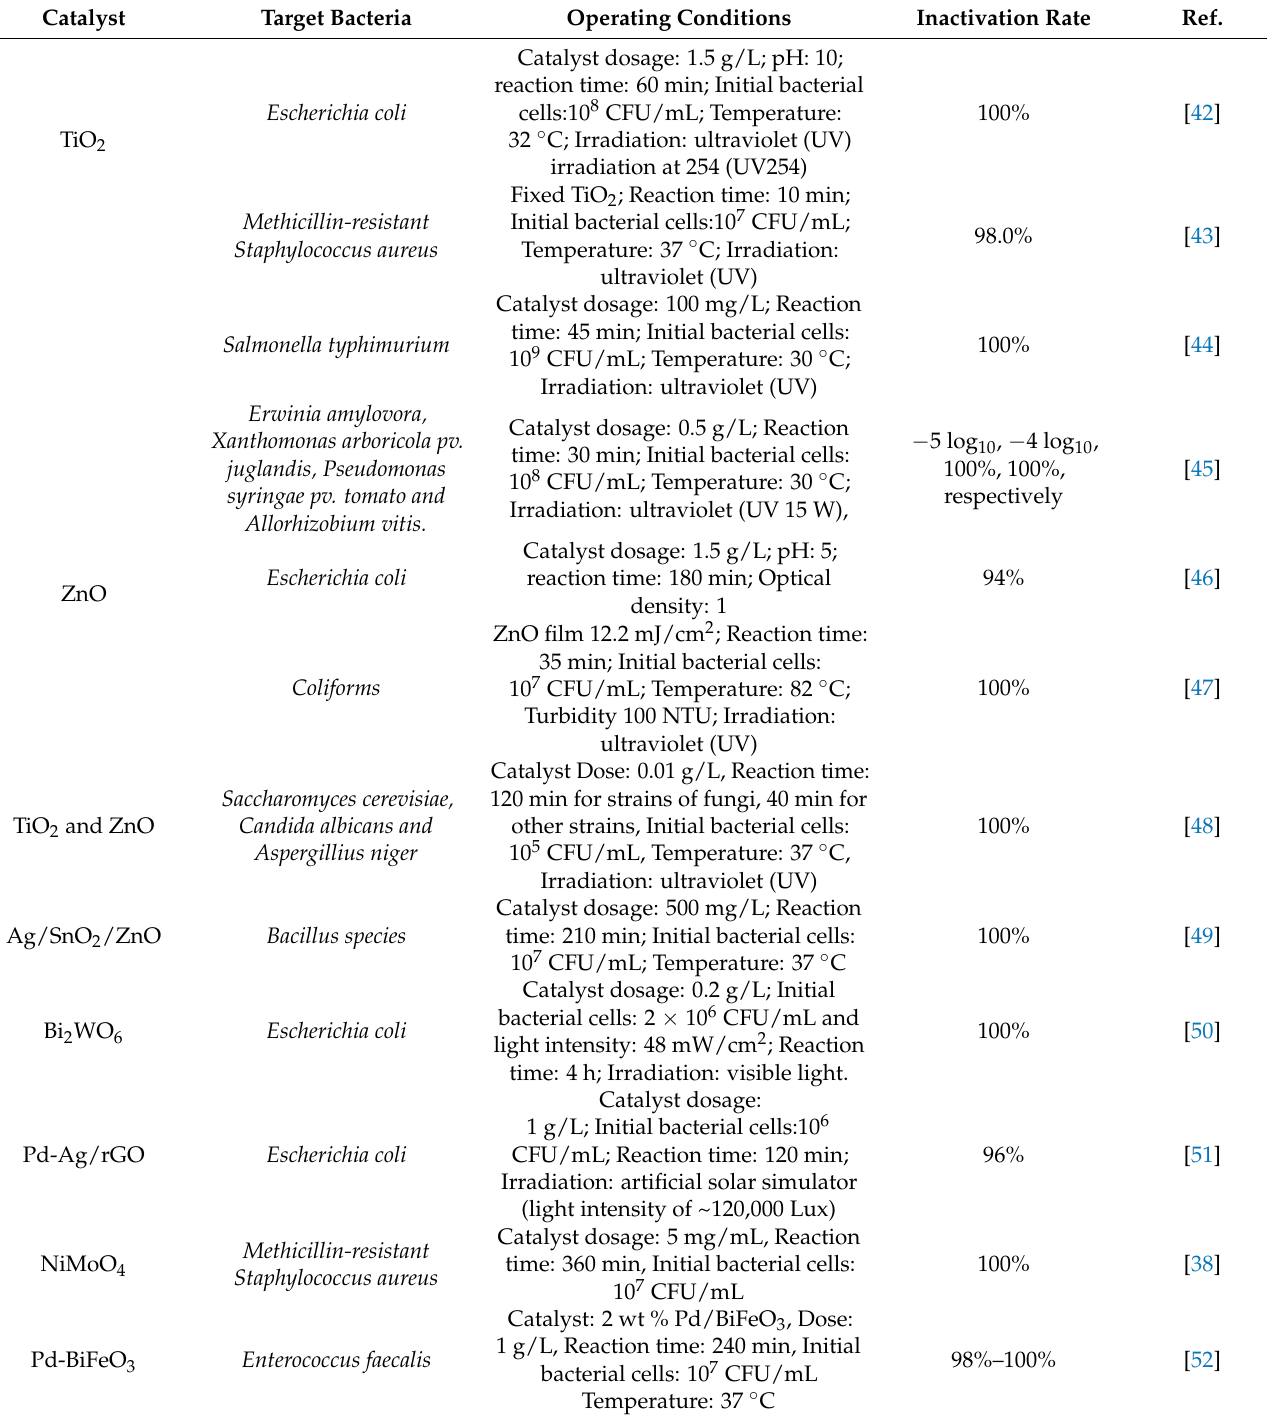
Table 1. Semiconductors for bacteria